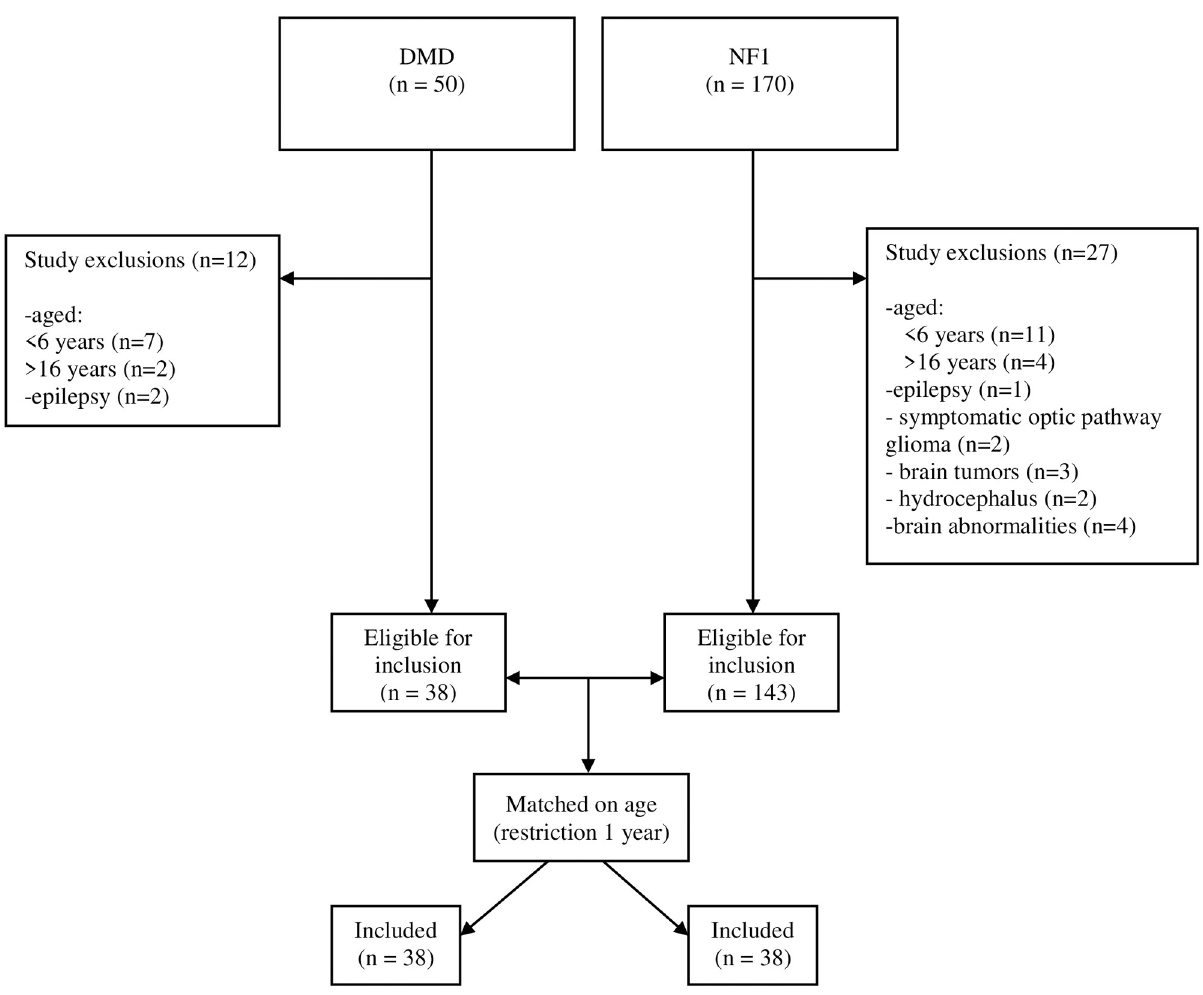
Fig 1. Flowchart of inclusion. Note: DMD = Duchenne muscular dystrophy, NF1 = Neurofibromatosis type 1.